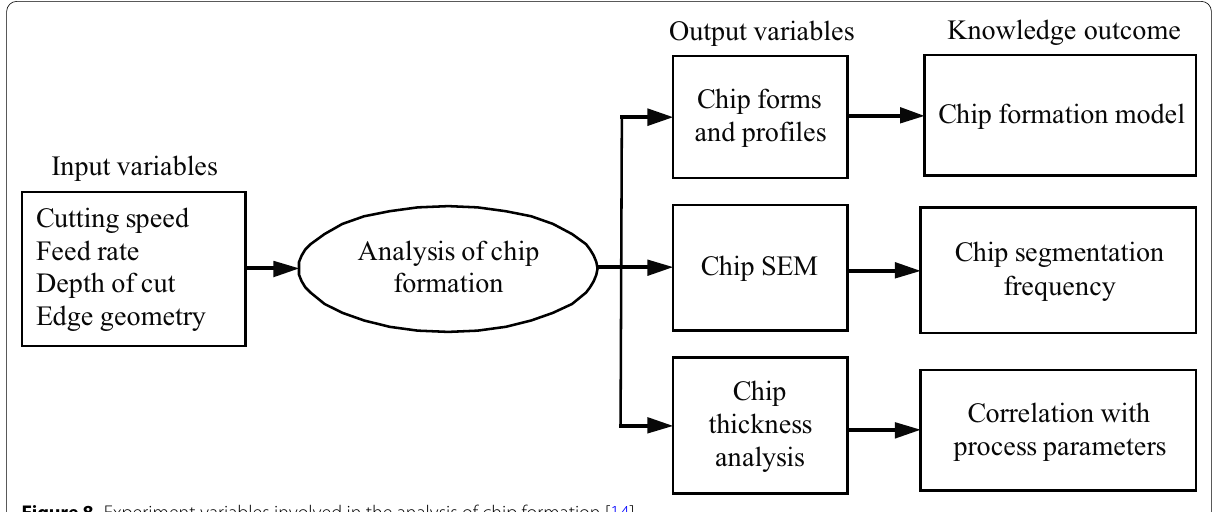
Figure 8 Experiment variables involved in the analysis of chip formation